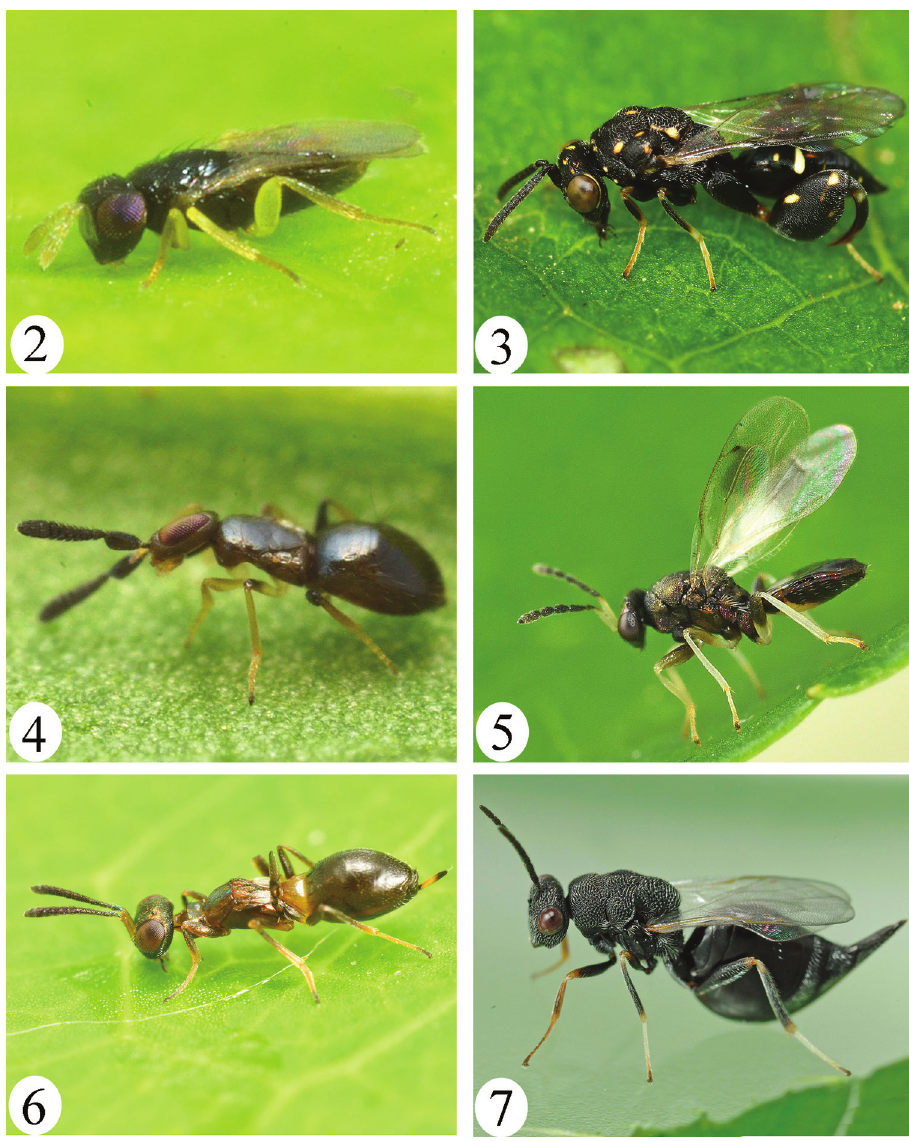
Figures 2–7. 2 Aphelinus sp. (Aphelinidae), Clear Creek, ON 3 Conura sp. (Chalcididae), near St. Williams, ON 4 Anusia nasicornis (Encyrtidae), near Marmora, ON. This is the most recent record of an Old World ge- nus and species in the New World, identified by J. Noyes in October, 2019 5 Eulophus sp. (Eulophidae), Fer- gus, ON 6 Eupelmus messene (Eupelmidae) drinking from a water droplet, Forks of the Credit Provincial Park, ON. Until recently, misidentified as the common, polyphagous species E. vesicularis ; the latter now recorded only from the Old World 7 Eurytoma gigantea (Eurytomidae), Fergus, ON. Photos courtesy of S.